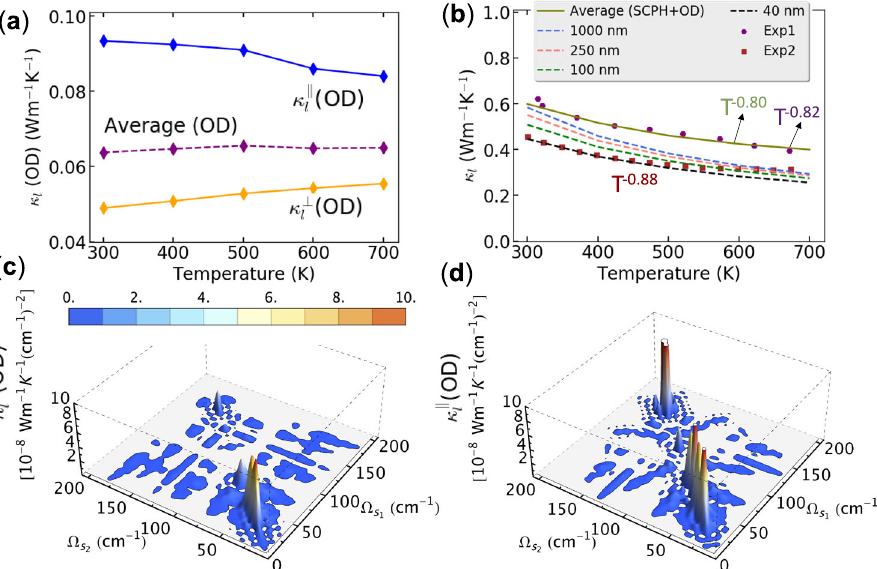
Fig. 4 Heat transport due to wave-like tunneling of phonons. a The off-diagonal (OD) contributions to κ l (i.e., κ k calculated using the anharmonically renormalized phonon frequencies at each temperature. b Total κ l (calculated within SCPH method) including the OD contributions reproduces the Exp1 38 well. Additional grain-boundary scatterings on top of SCPH + OD contributions to κ l reproduce Exp2 39 . Grain sizes ranging from 40 to 1000 nm are considered here. Three-dimensional visualizations of the mode speci fi c contributions to κ l (OD) as a function of anharmonically renormalized phonon frequencies (i.e., Ω s ) at T = 300 K for the c κ ? components. These quantities are plotted per cross-sectional area of the Brillouin zone to clearly highlight the phonon frequencies that primarily contribute to the κ l (OD). A color scale corresponding to the variation of colors in c and d is shown, which has the same unit as indicated in the z -axes of both fi